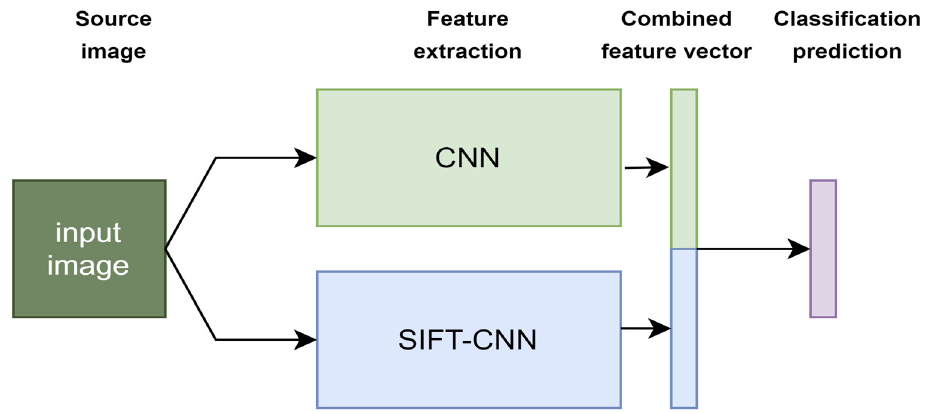
Figure 4. The proposed late fusion of the pixel-CNN and SIFT-CNN scheme. A given image is fed into the pixel-CNN, producing a 512-dimensional vector as well as to the SIFT-CNN, producing another 512-dimensional vector. These two vectors are concatenated (resulting in a final combined feature vector with 1024 dimensions) and then fed to a fully connected layer for the final class prediction into seven cloud categories.